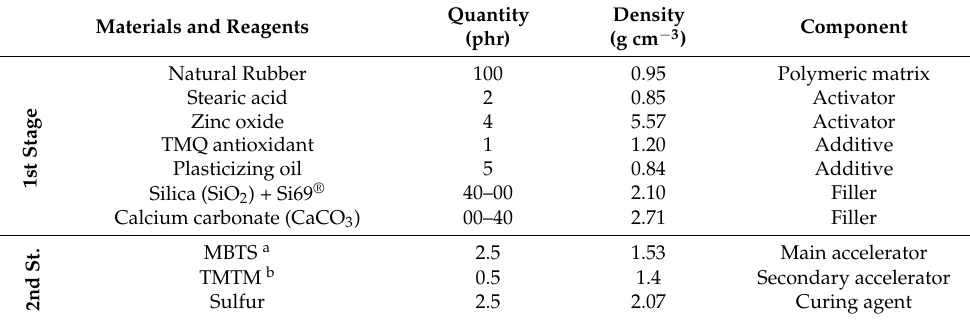
Table 1. Standard vulcanization formulation [28].